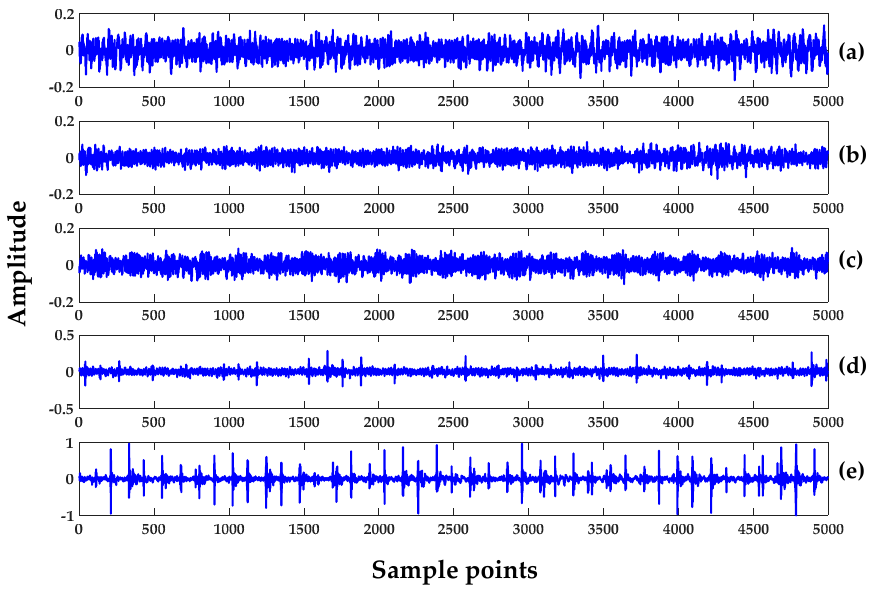
Figure 3. Time-series of REB for Case 1 of same segment set: ( a ) Healthy set 1 (H1); ( b ) Healthy set 2 (H2); ( c ) Damage set 1 (D1); ( d ) Damage set 2 (D2); and ( e ) Damage set 3 (D3).